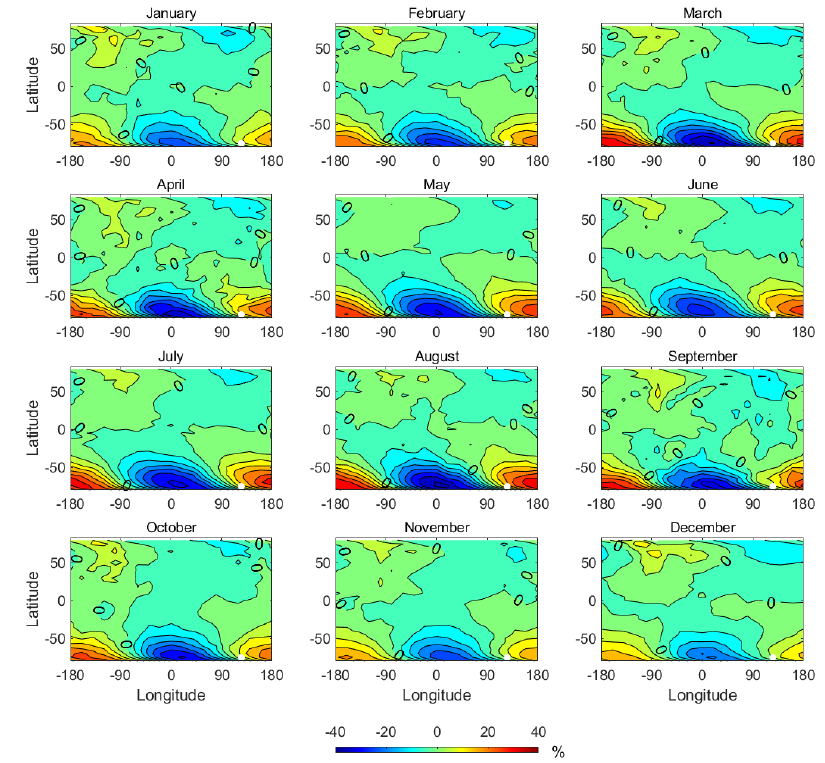
Figure 7. Same as Figure 3, except for the MSIS 2.0 model predictions.